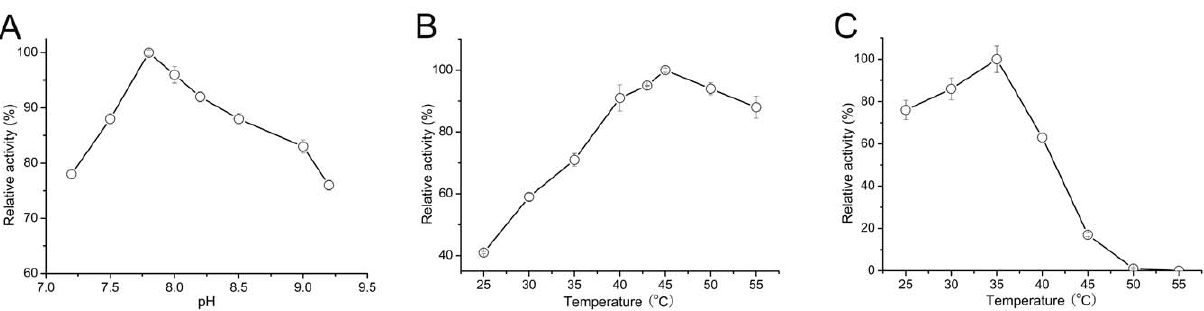
Figure 2. Effects of pH and temperature on the activity of purified SmIDH. (A) Effects of pH on SmIDH activity was measured with the pH range of 7.2–9.2. (B) Effects of temperature on SmIDH activity was measured from 25 u C to 55 u C. (C) Heat-inactivation profiles of SmIDH. The enzyme activity was measured from 25 u C to 55 u C.